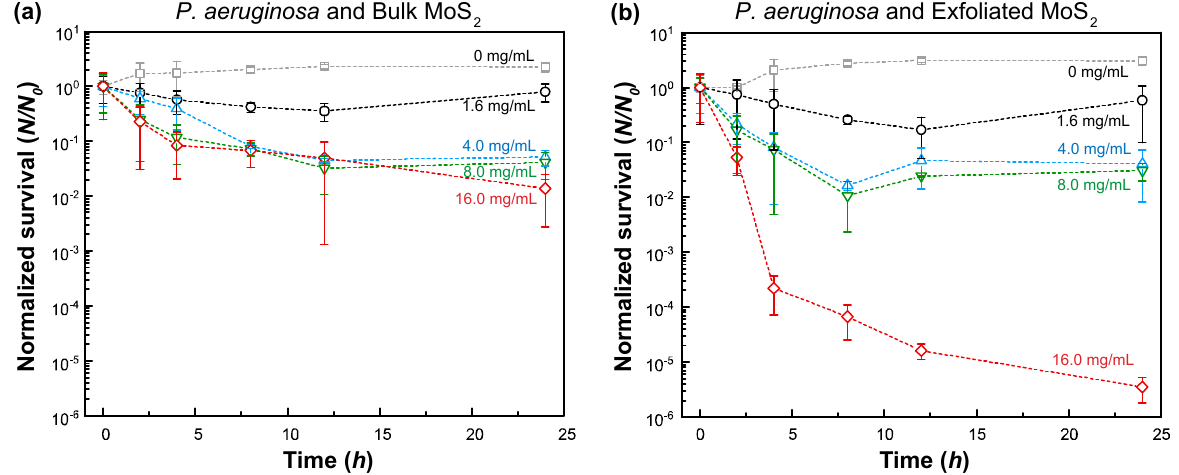
Figure 4. Normalized (with respect to initial concentration) survival of P. aeruginosa in peptone water and MoS 2 suspension inoculated with ( a ) bulk MoS 2 and ( b ) exfoliated MoS 2 . The error bars represent the standard error of the mean.